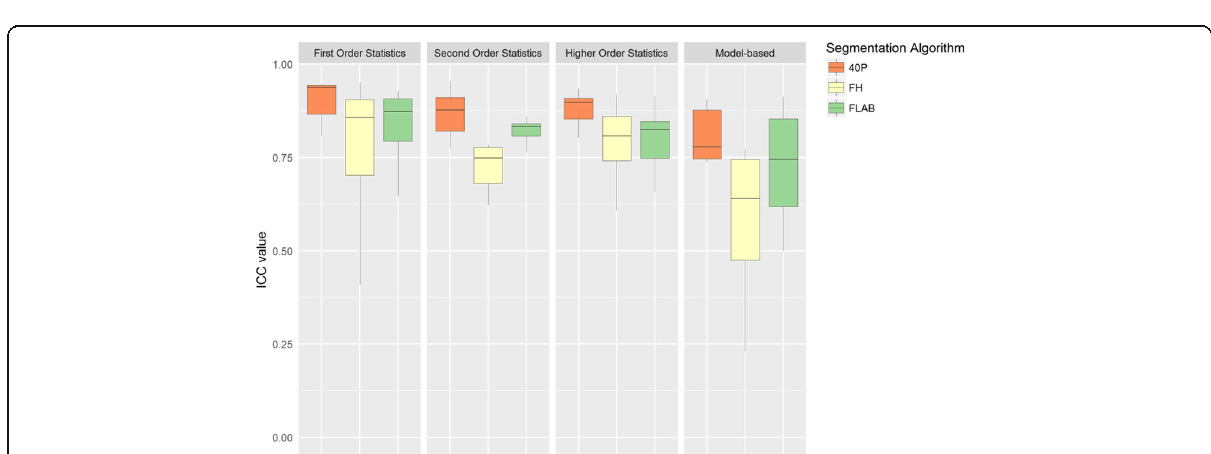
Fig. 3 Boxplots comparing ICC values for the three segmentation algorithms over the four groups of texture parameters, i.e. first-order, second-order, and higher-order statistics, and model-based parameters. 40P 40% of maximum intensity threshold. FH freehand, FLAB fuzzy locally adaptive Bayesian, ICC intraclass correlation